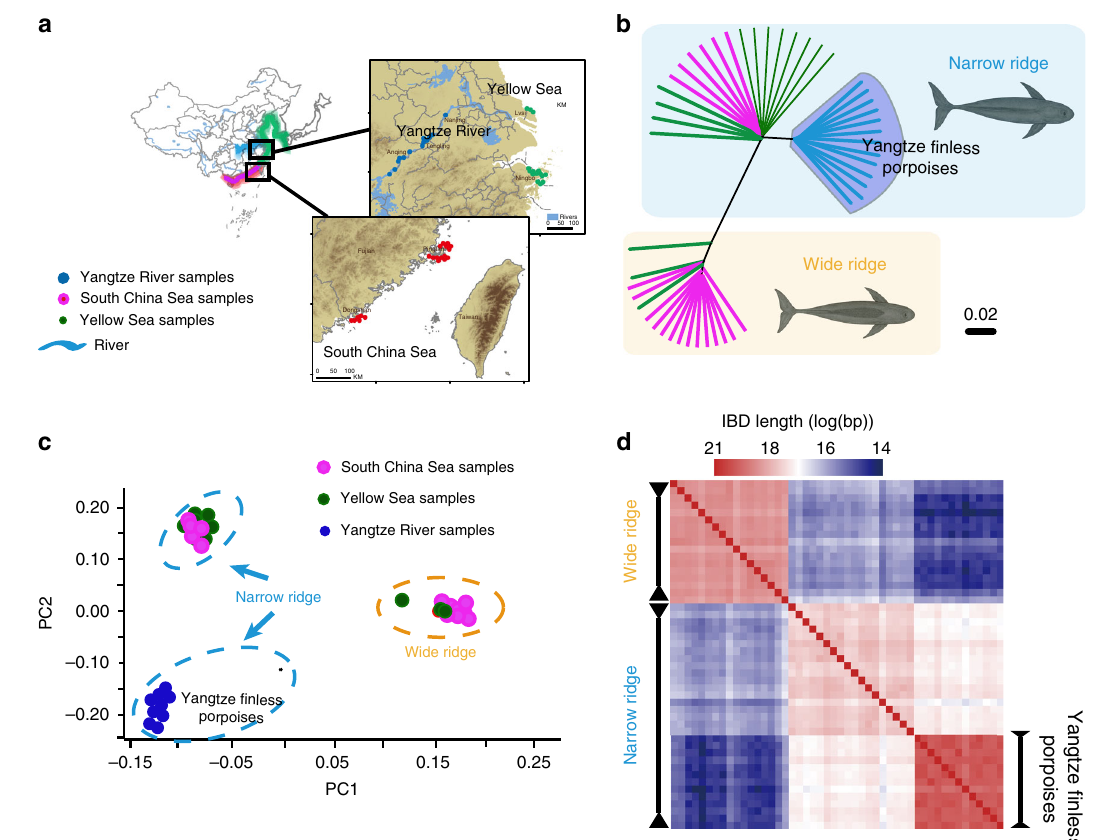
Fig. 1 Phylogeny and population structure of fi nless porpoises. a Current geographic distribution of the fi nless porpoise. The map was retrieved from http:// www.naturalearthdata.com (Public Domain; date accessed: Feb 2017) and generated using ArcGIS 9.3 62 . b Neighbor-joining tree constructed from the allele-sharing matrix of variants of 48 fi nless porpoises. The fi nless porpoise images were created by Chen Yu in Adobe Photoshop CS6. c Principal components analysis (PCA) of 48 fi nless porpoises. In particular, the fi rst eigenvector separate the two main morphological forms, i.e., the wide-ridged form and narrow-ridged (variance explained = 12.92%, Tracy – Widom P = 3.26 × 10 − 11 ), and the second eigenvector separate the Yangtze River population from the other narrow-ridged individuals (variance explained = 2.53%, Tracy – Widom P = 8.72 × 10 − 50 ). d Estimated haplotype sharing in the fi nless porpoises. The heat map colors represent the total length of IBD blocks for each pairwise